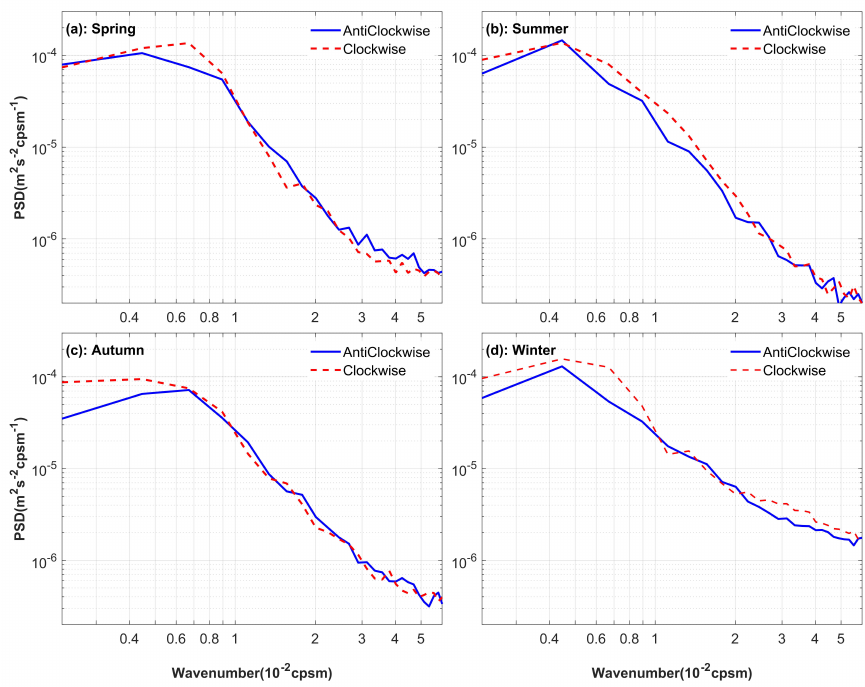
Figure 4. Rotary Vertical Wavenumber spectra of near-inertial currents for ( a ) spring, ( b ) summer, ( c ) autumn, and ( d ) winter. The blue and red lines represent the anticlockwise and clockwise rotating with a depth component. The unit of vertical wavenumber is cycles per stretched meter